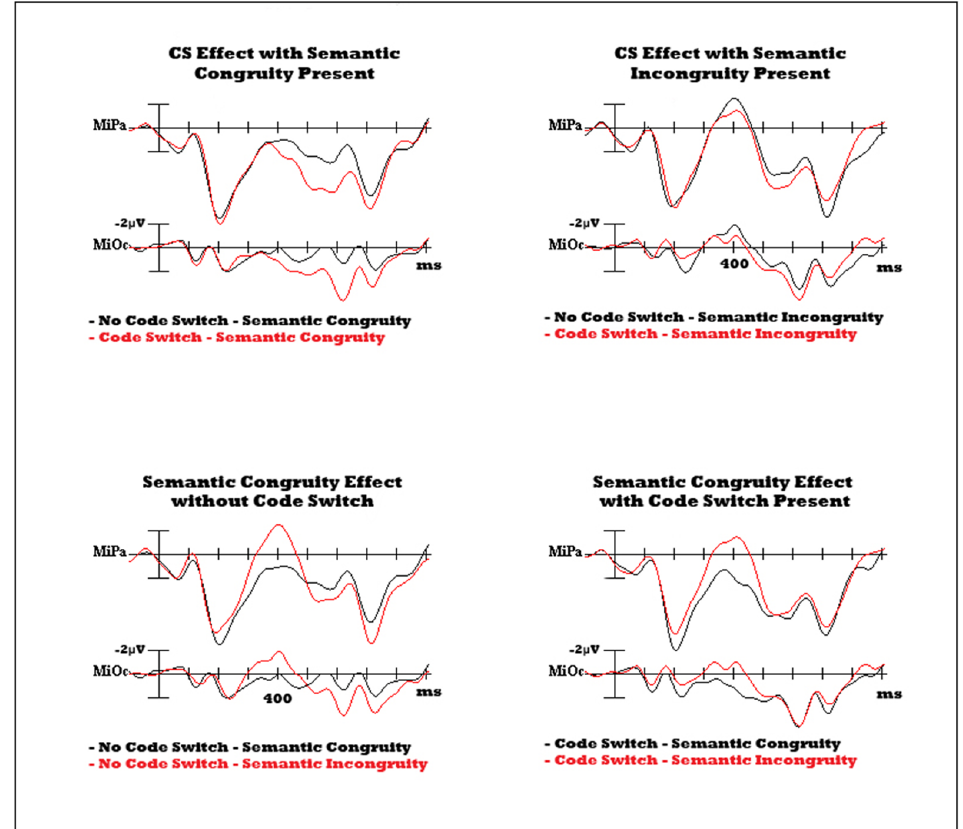
Figure 4. Interactions of code-switching and semantic congruity.